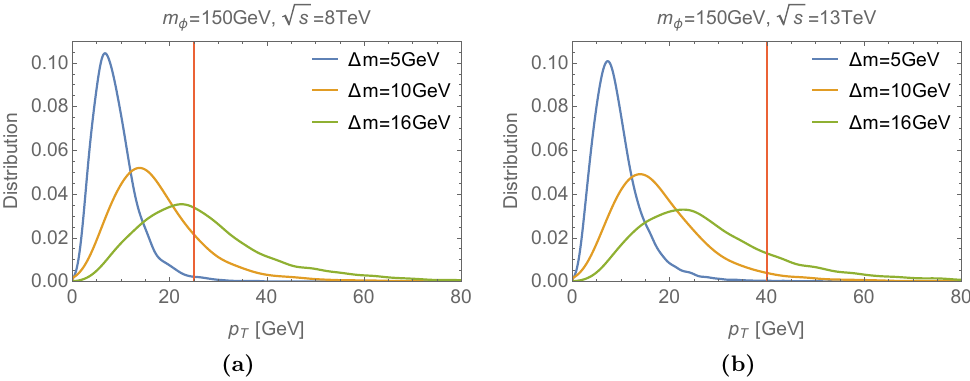
Figure 7 . The p T -distribution of the leading muons for the case when m (cid:30) = 150 GeV and di(cid:11)erent values of the mass splitting. The red vertical line denotes the cut on the p T that is made in the p p search [67, 68] at 25 GeV for s = 8 TeV (left) and 40 GeV for s = 13 TeV (right). of the signal includes a pair of displaced leptons and a pair of dark matter particles.